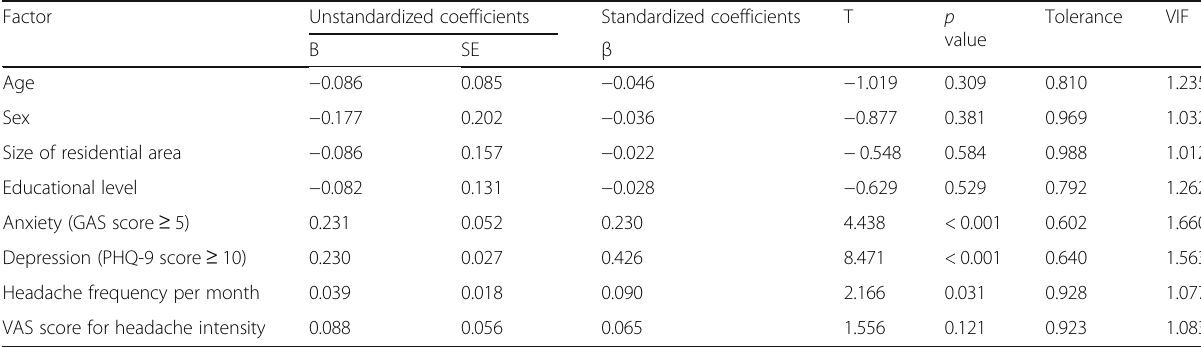
Table 4 Analysis a of contributing factors related to the total PSQI score in participants with probable